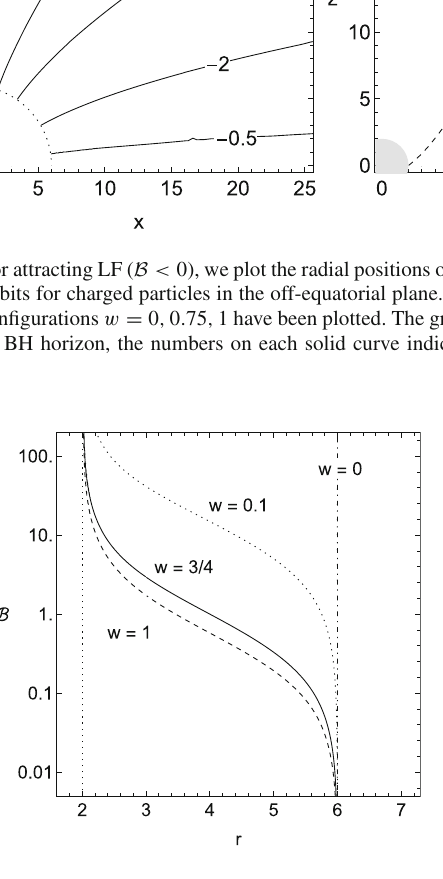
Fig. 4 For repulsive LF ( B > 0), we plot the radial positions of the inISCOs for charged particles in equatorial plane, with different MF configurations w = 0 , 0 . 1 , 0 . 75 , 1. The dotted vertical line shows the position of the BH horizon, while the dot-dashed vertical line indicates the position of the inISCO for a neutral